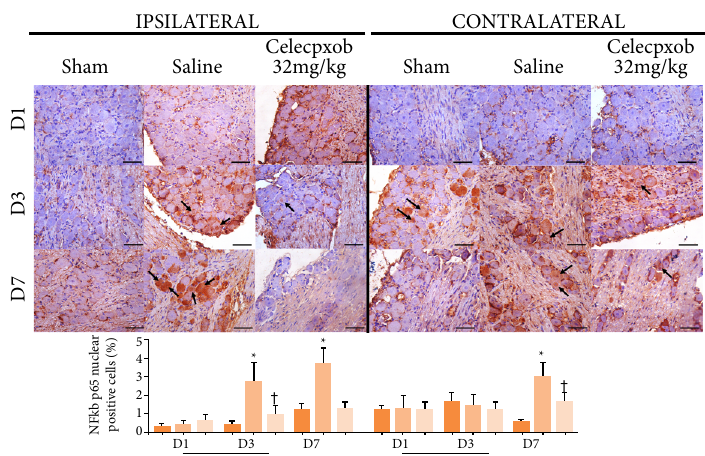
Figure 4 - NFkB p65 immunostaining of cell bodies of trigeminal neurons after one, three, and seven days of exposure to an experimental model of dental occlusal interference in rats treated with a selective cyclooxygenase 2 inhibitor (celecoxib, Eurofarma ® ). One-way ANOVA/Bonferroni (mean ± standard error). Immunohistochemistry, 400×, horizontal line = 50 μ m.